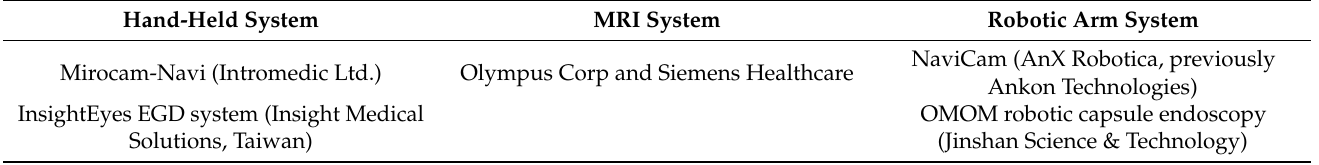
Table 1. Systems of MCE used in clinical